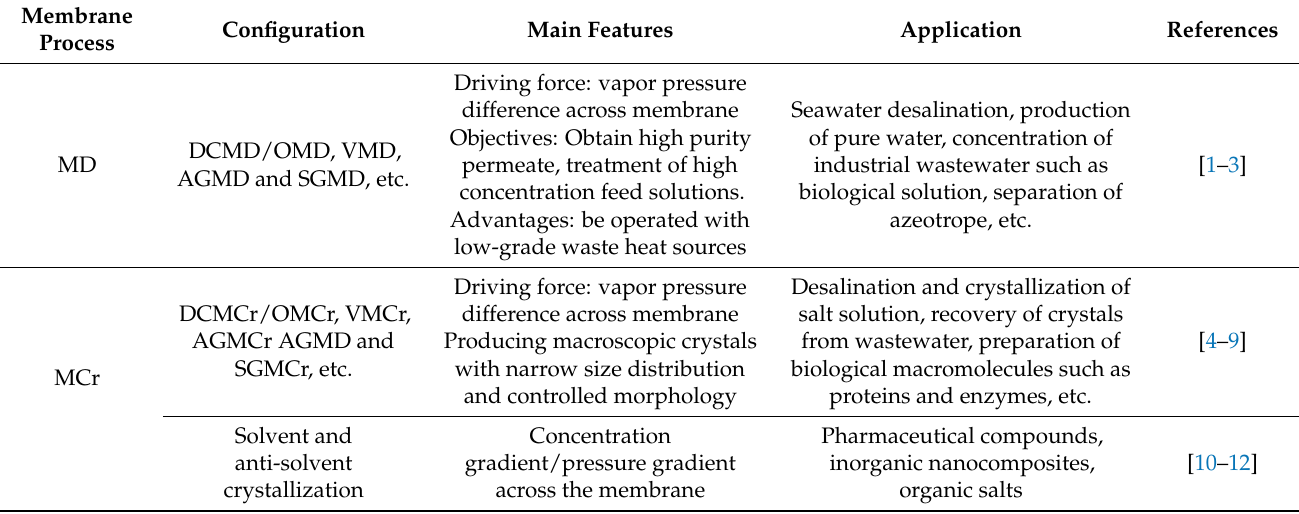
Table 1. Main characteristics of MD and MCr.